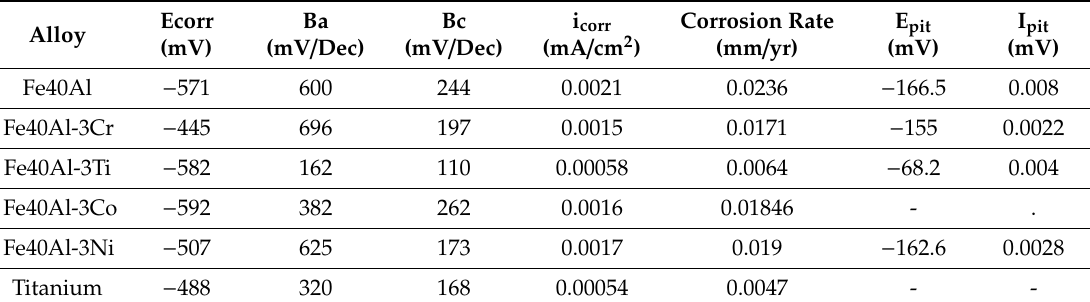
Figure 2. Potentiodynamic polarization curves of the alloys exposed to artificial saliva. Table 2. Electrochemical parameters of the Fe40Al based alloys tested in artificial saliva at room